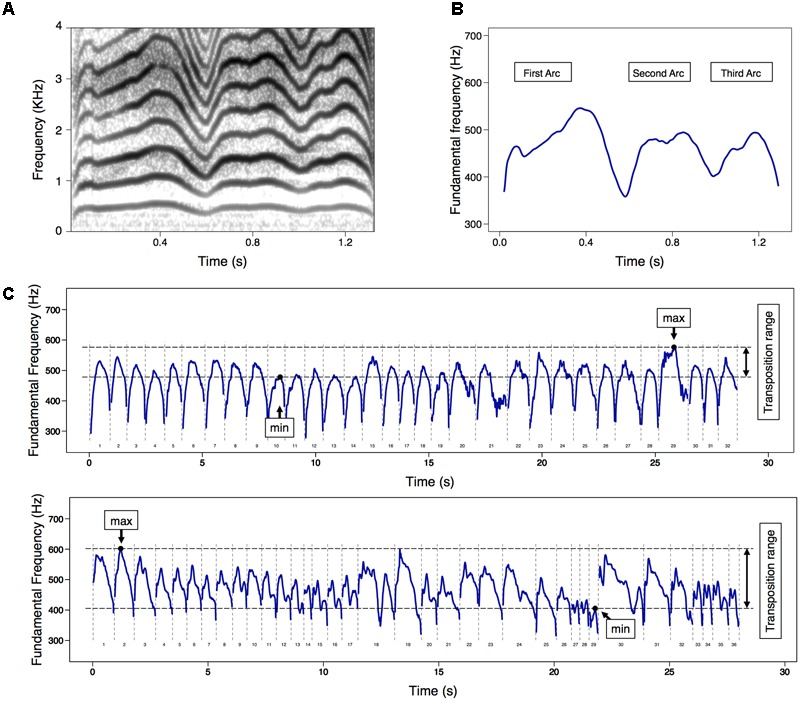
(A) An example of spectrogram and (B) corresponding melody (i.e., time series of fundamental frequency [F0]) contour diagrams for a complex cry with multiple-arcs. (C) Two examples of melody contours in a series of spontaneous cries in 60 s, indicating the F0 transposition range, which means the difference between minimum and maximum values among F0 max. The upper diagram indicated a smaller F0 transposition range (98 Hz [478–576], 3.24 semitones), while the bottom one indicated a greater F0 transposition range (197 Hz [405–602], 6.85 semitones). Not included in the diagrams were cry utterances excluded from the main analysis, respiratory phases, and no-phonatory periods.